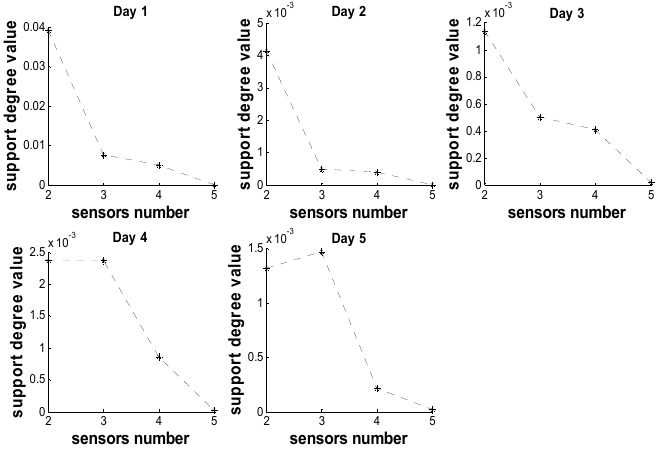
Figure 9. Support degree value of sensors to Sensor 1.